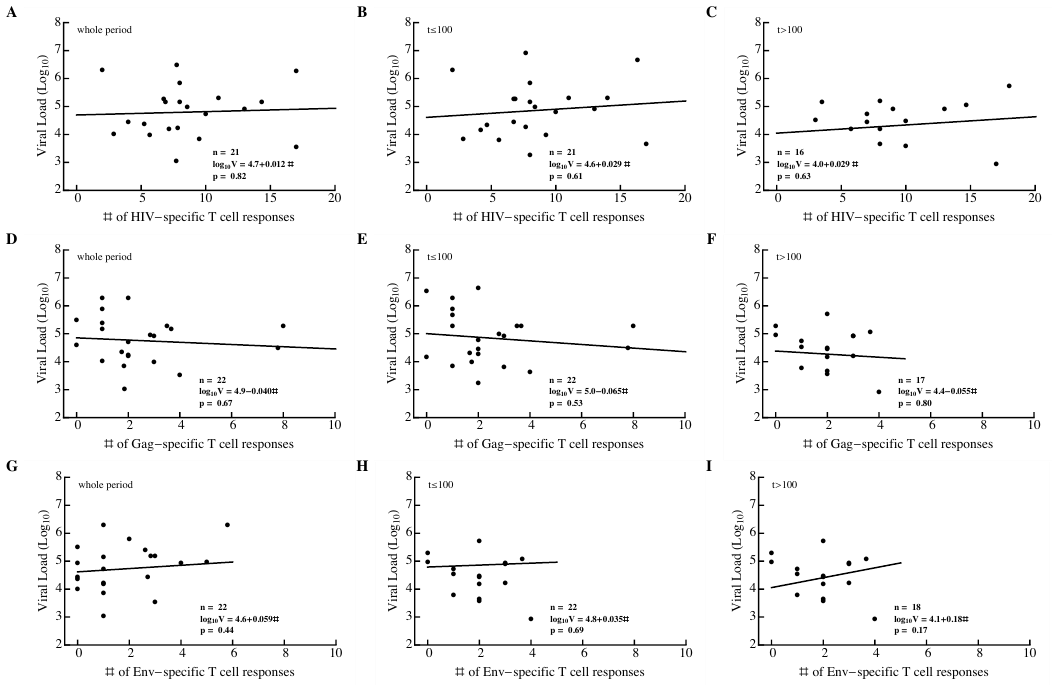
Figure 4. Breadth of HIV-specific CD8 + T-cell response in a patient does not correlate significantly with average viral load. We calculated the average number of HIV-specific ( A – C ), Gag-specific ( D – F ), and Env-specific ( G – I ) CD8 + T-cell responses over the whole observation period ( A , D , G ), during acute infection ( t ≤ 100 days since symptom onset; ( B , E , H )), or during chronic infection ( t > 100 days since symptom onset; ( C , F , I )) and log average viral load in that time period. The average viral load 10 during infection was not dependent on the breadth of the Gag-specific CD8 + T-cell response during the infection ( D – F ). Patient SUMA0874 was excluded from the analysis in ( A – C ) due to insufficient measurements of all T-cell responses at all time points.